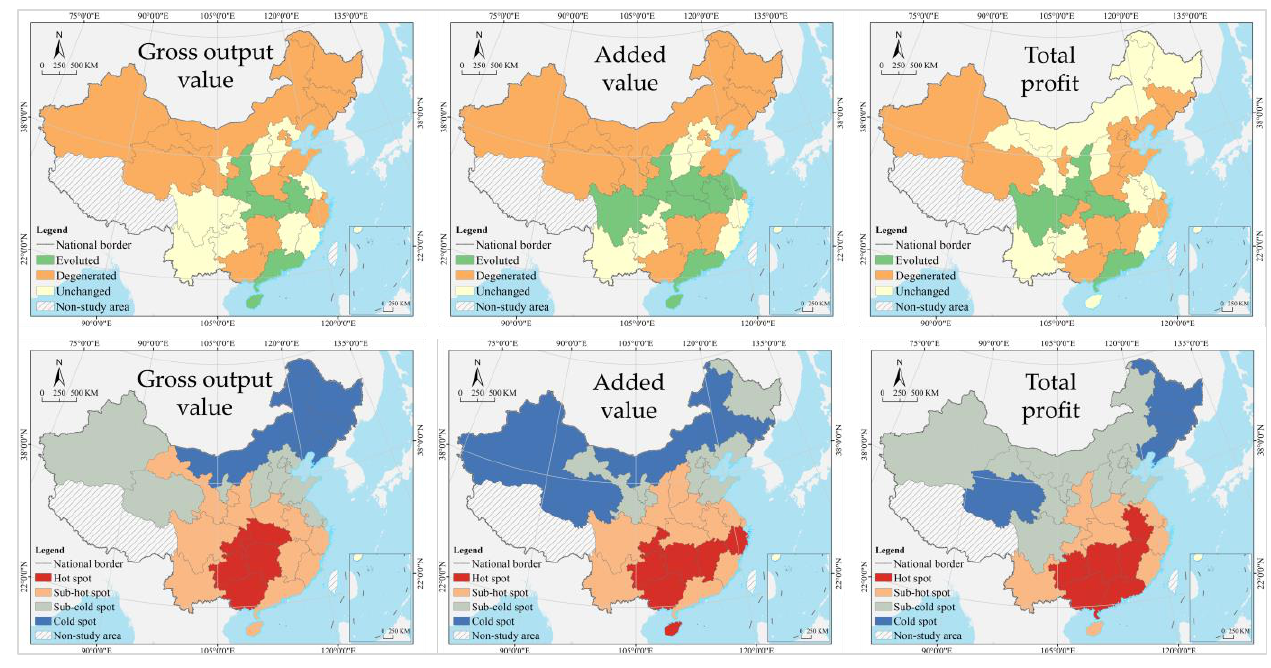
Figure 15. Spatial distribution and gathering characteristics of decoupling change types.